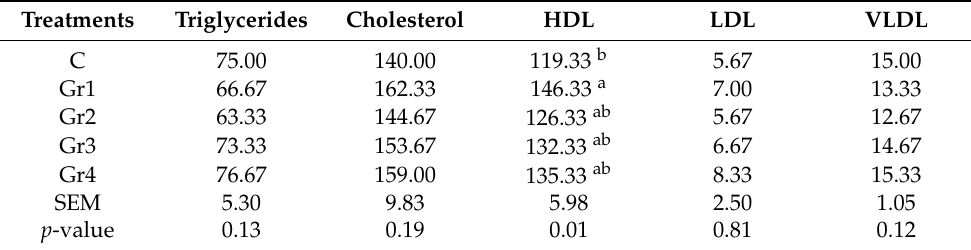
Table 7. Effects of variable concentrations of dietary CP and Lys on serum lipid profile of broiler